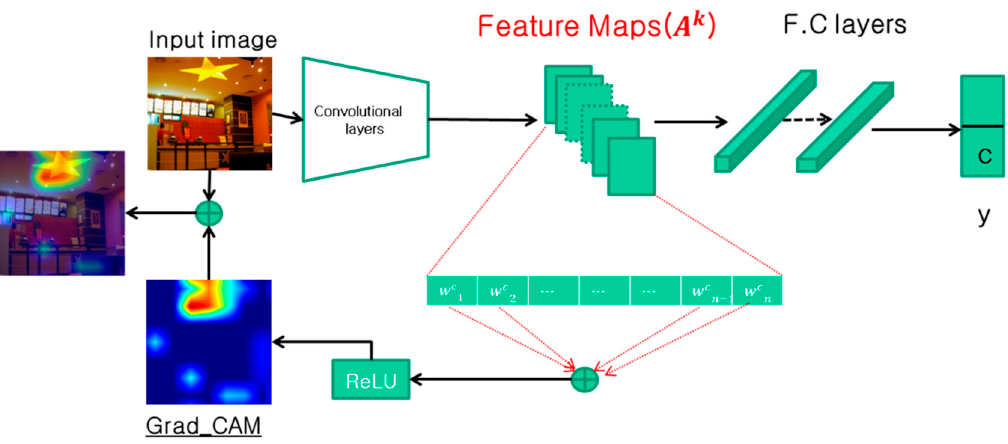
Figure 3. Structure of Grad-CAM for generating a heat map reflecting the user’s preference based on atypical features.